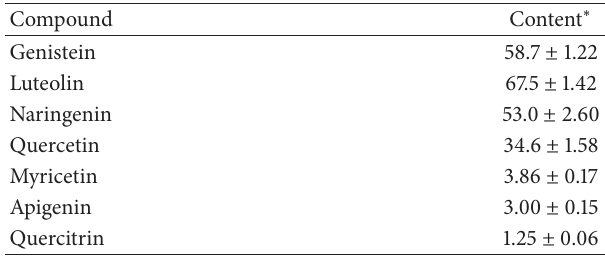
Table 3: The content of flavonoids in Genista tinctoria extract.